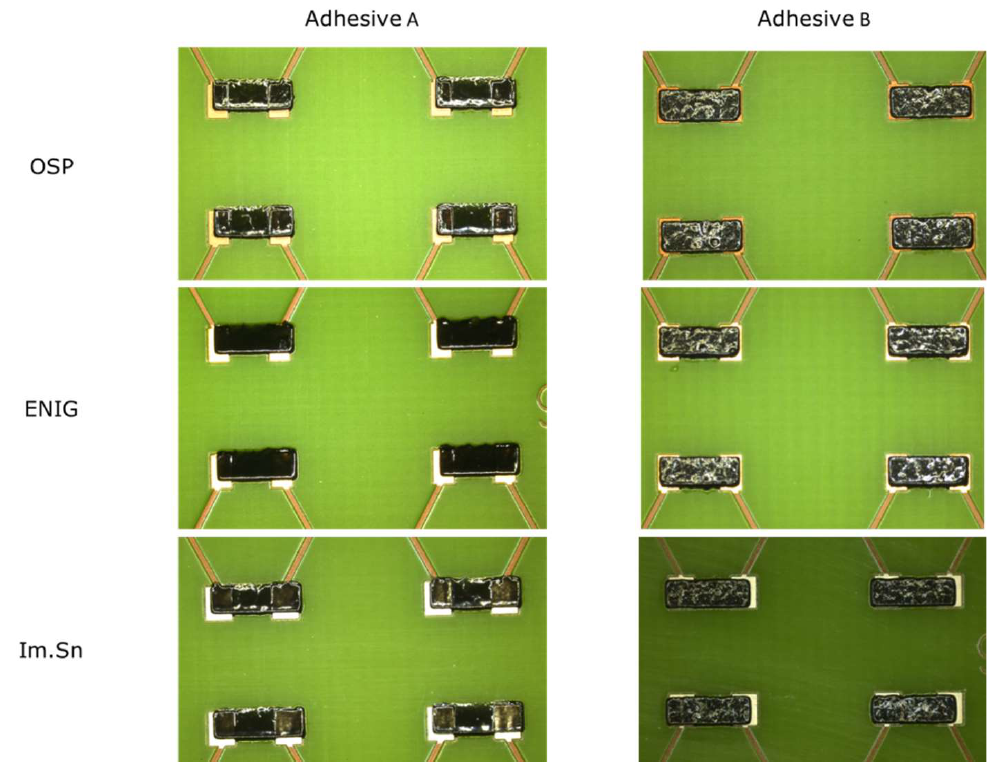
Figure 10. Images of the prototype boards after adhesive deposition and curing.